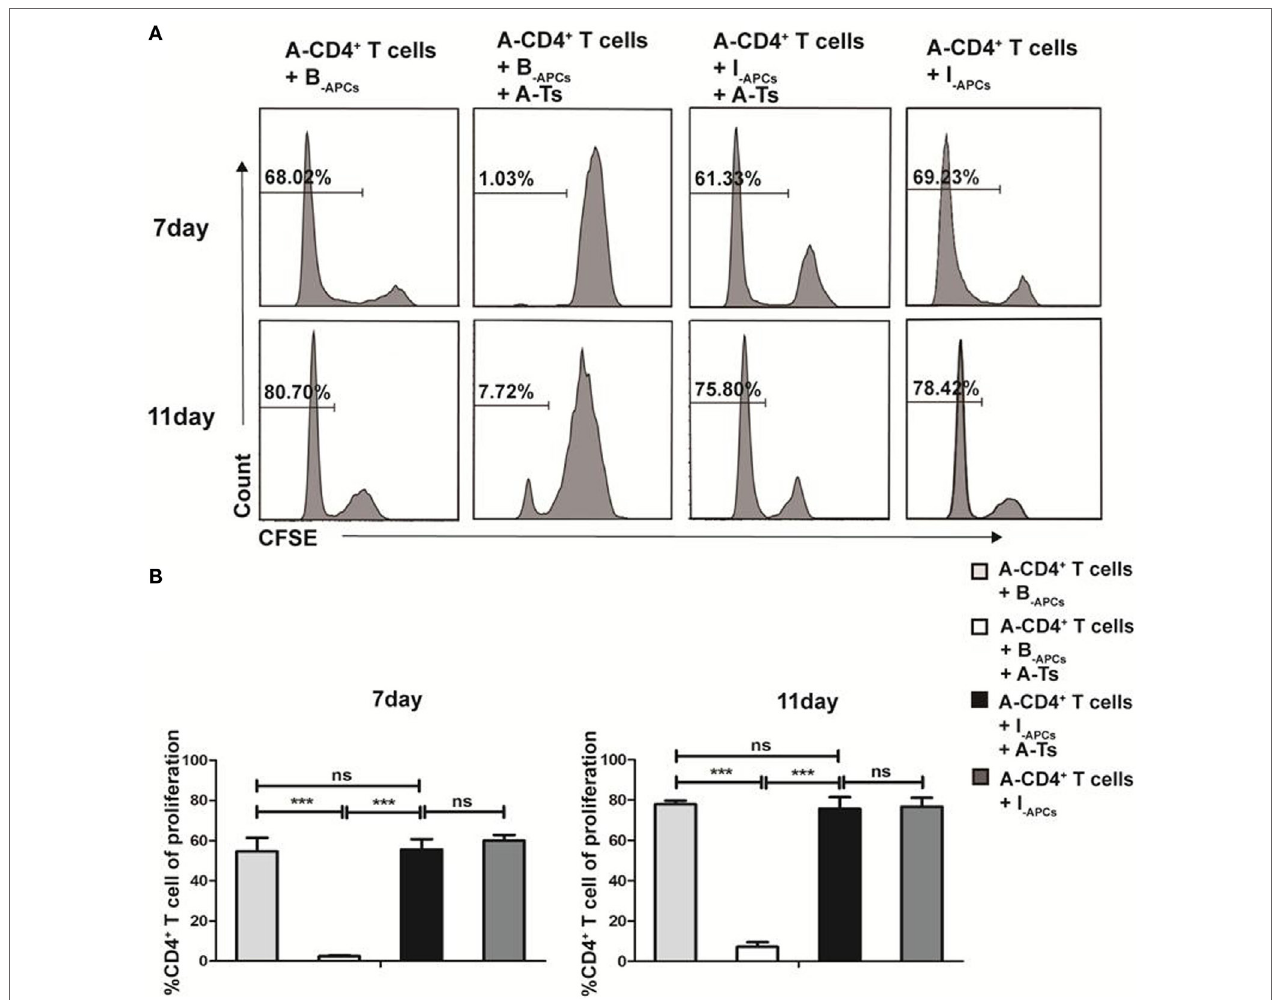
FigUre 3 | CD8 + CD28 − T cells expanded by IL-15 inhibit the proliferation of CD4 + T cells in an allospecific manner in vitro . 5 × 10 4 carboxyfluorescein diacetate succinimidyl ester (CFSE)-labeled responder CD4 + T cells (R) from donor A were stimulated with 5 × 10 4 antigen-presenting cells (APCs) from donor B (B -APCs ) or indifferent donor I [I -APCs , human leukocyte antigen (HLA)-A, -B, and -DR fully mismatched with donor B and donor A] in the presence of absence of 5 × 10 4 CD8 + CD28 − T cells (A-Ts) in triplicates in 96-well plates for 7 and 11 days. (a) The proliferation of CD4 + T cells was measured by CFSE dilution. (b) The percentages of proliferating CD4 + T cells were compared. The bar graphs indicate the means ± SD, n = 3. * p < 0.05, ** p < 0.01, and *** p <